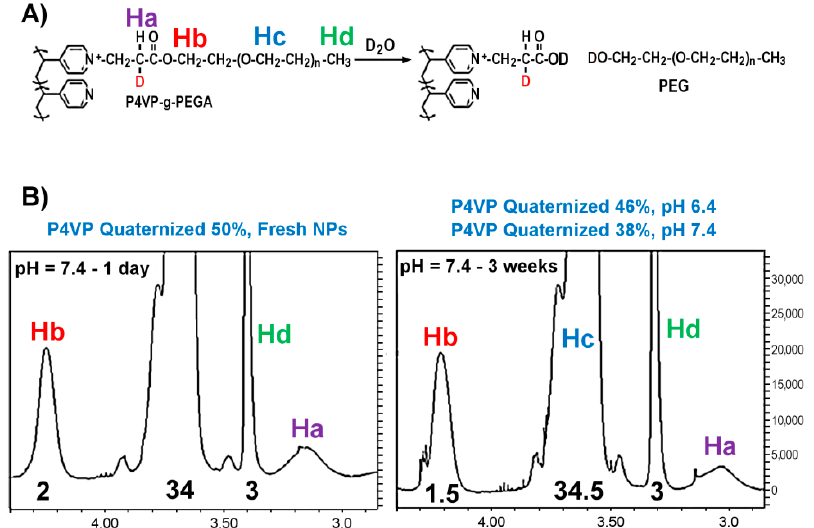
Figure 8. Time influence on the stability of the polymeric coating of PEG coated IONPs. Hydrolysis of ester groups present on the P4VP-g-PEG IONP coating at day 1 (A) and 3 weeks later (B).